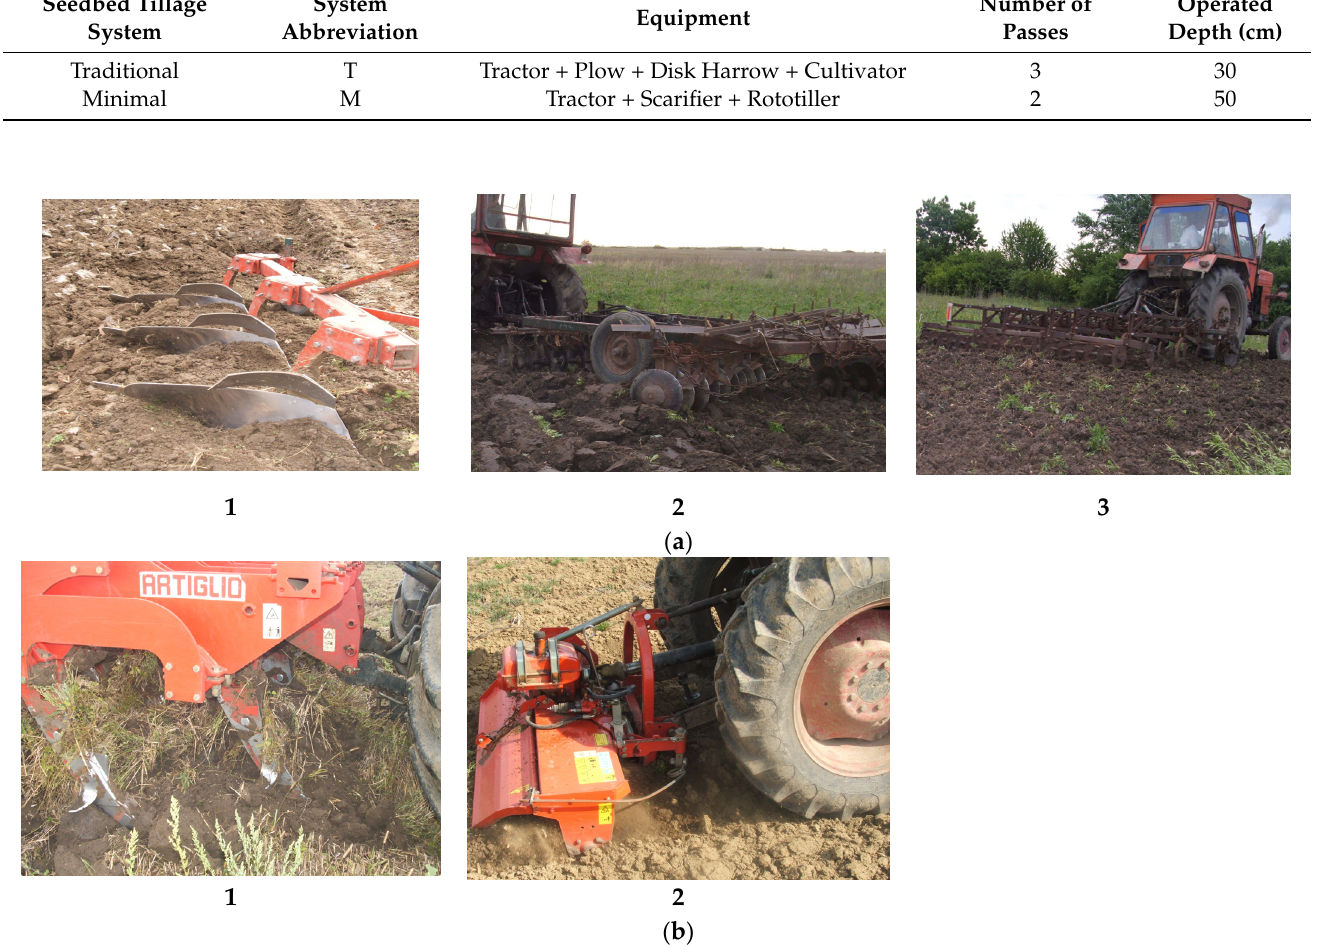
Table 2. Description of the equipment used in the two seedbed tillage systems.